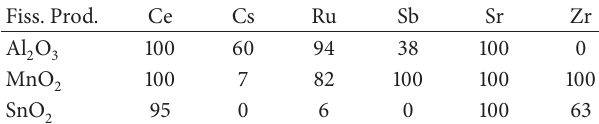
Table 1: Dynamic retention behavior of fission product traces on inorganic exchanger columns: loading solution: 10mL, washing